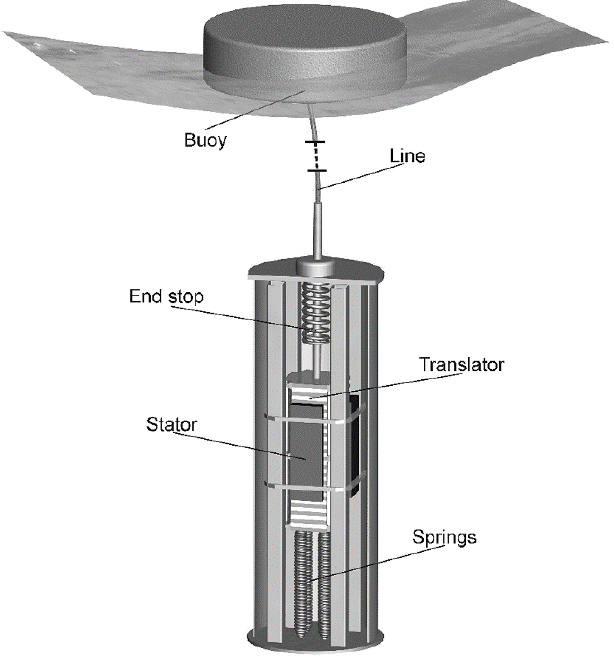
Figure 1. WEC concept developed at Uppsala University. No springs are present for the L12 version and WEC model in this